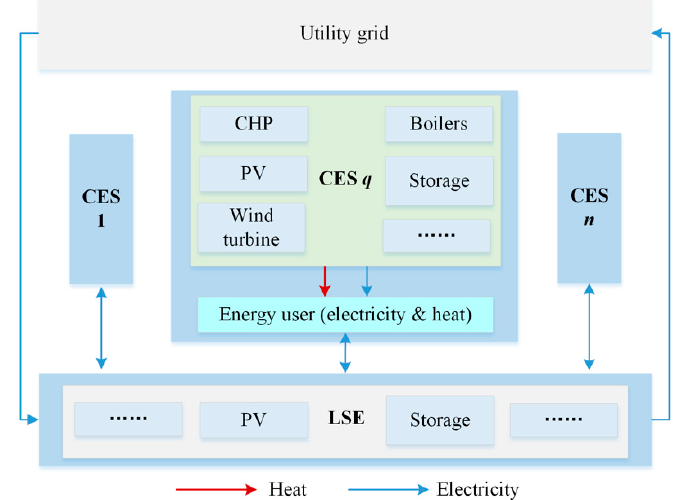
Figure 1. The underlying structure of the load service entity (LSE) and community energy systems (CESs).